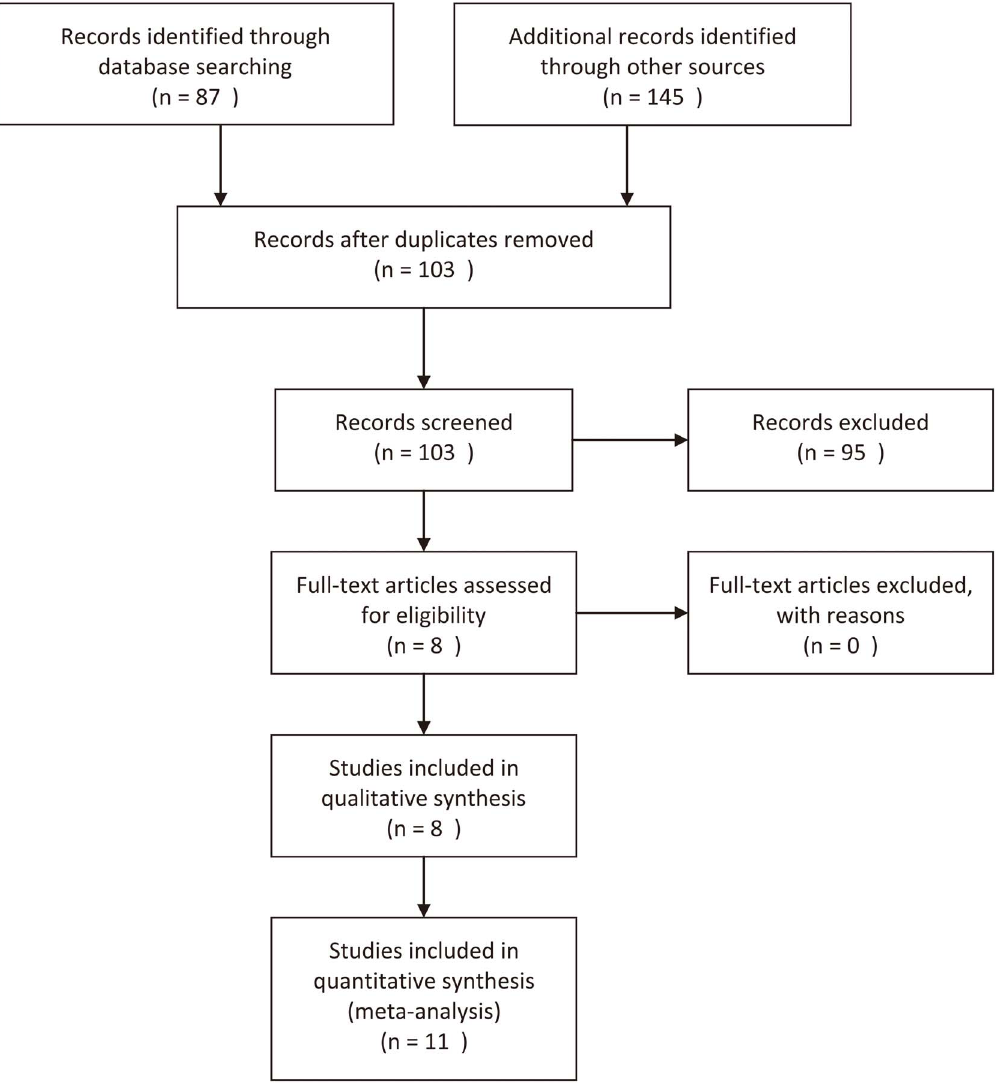
Figure 1. Flow chart of study identification. In the articles by Naidu and Lu, they reported 3 studies and 2 studies separately, respectively, and each of them was treated as an independent study. Thus, a total of 11 studies were included in quantitative synthesis.